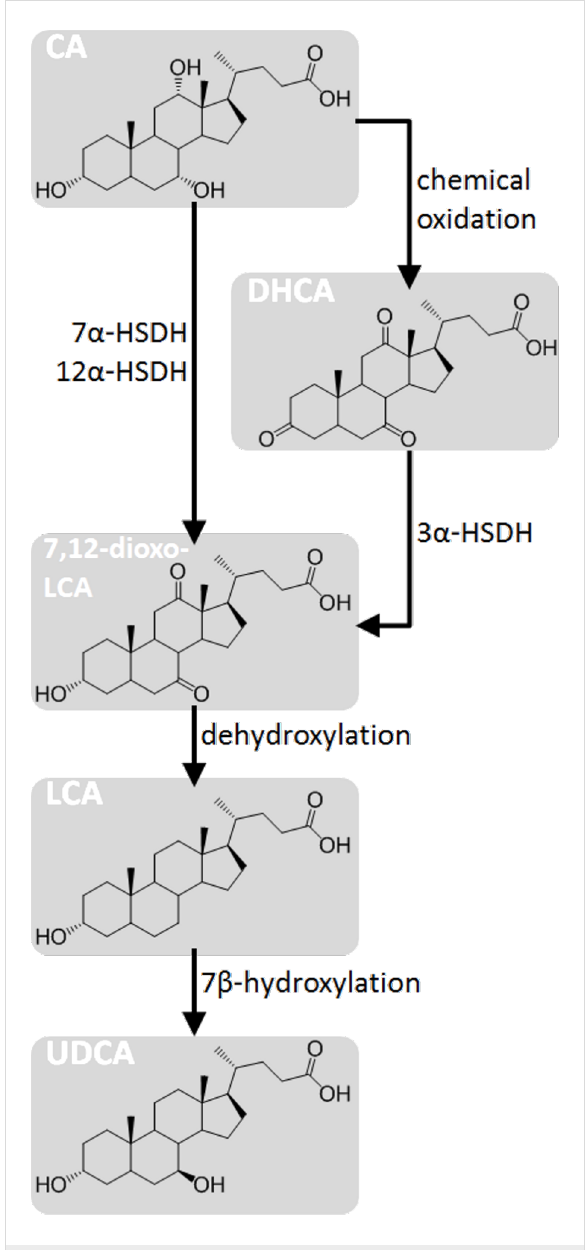
Figure 8: Chemoenzymatic pathways for the formation of UDCA from CA that profit by the C7 hydroxylation activity described by Sawada et al. [95]. CA can be transformed to 7,12-dioxo-LCA trough specific oxi- dation of 7 α -OH and 12 α -OH with a 7 α -HSDH and 12 α -HSDH, respec- tively. Alternatively, 7,12-dioxo-LCA can be obtained by chemically oxidizing (e.g., with CrO 3 ) all the hydroxy groups, yielding DHCA and then reducing the 3-oxo group to 3 α -OH by a 3 α -HSDH. LCA can be obtained from 7,12-dioxo-LCA through dehydroxylation by Wolff–Kishner or Mozingo reduction. Finally, UDCA can be obtained from LCA by 7 β -hydroxylation. The general stereoinformation of the steroid scaffold is shown in Figure